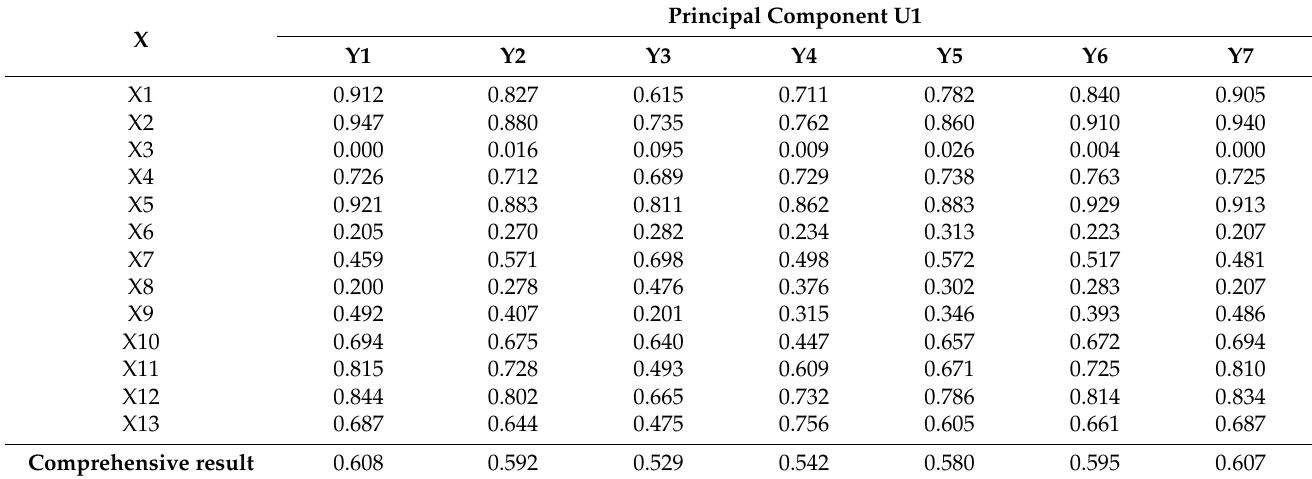
Table 7. Accuracy analysis of the principal component U1 and